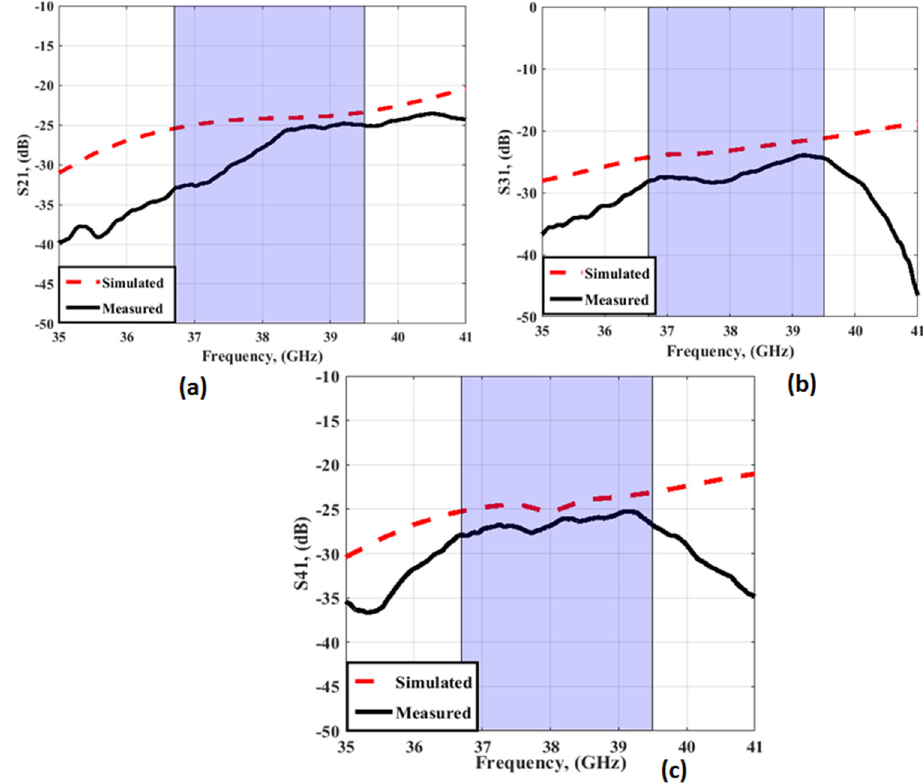
Figure 13. The simulated transmission coefficients of the MIMO antenna at port 1 ( a ) S 21 ( b ) S 31 ( c ) S 41 .